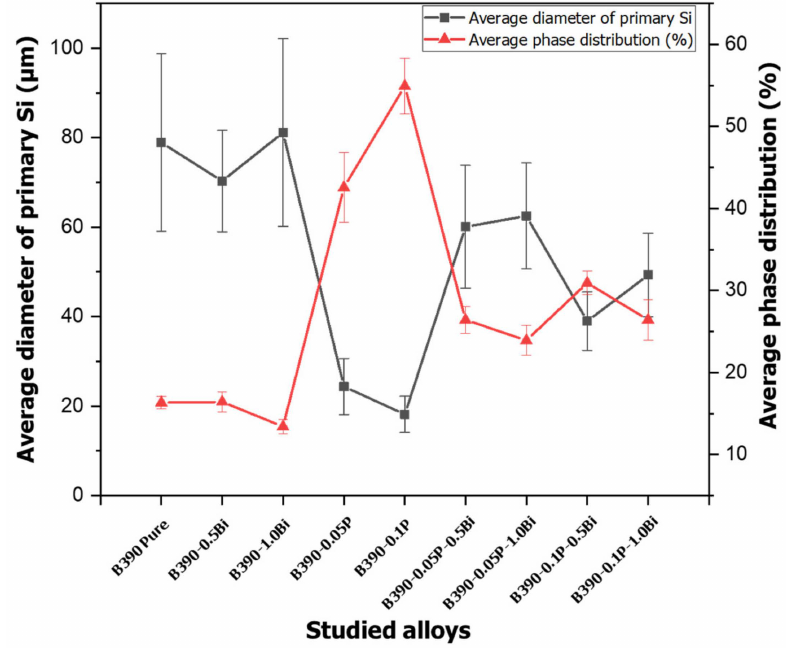
Figure 4. Average diameter and phase distribution of the primary Si of B390 and modified B390